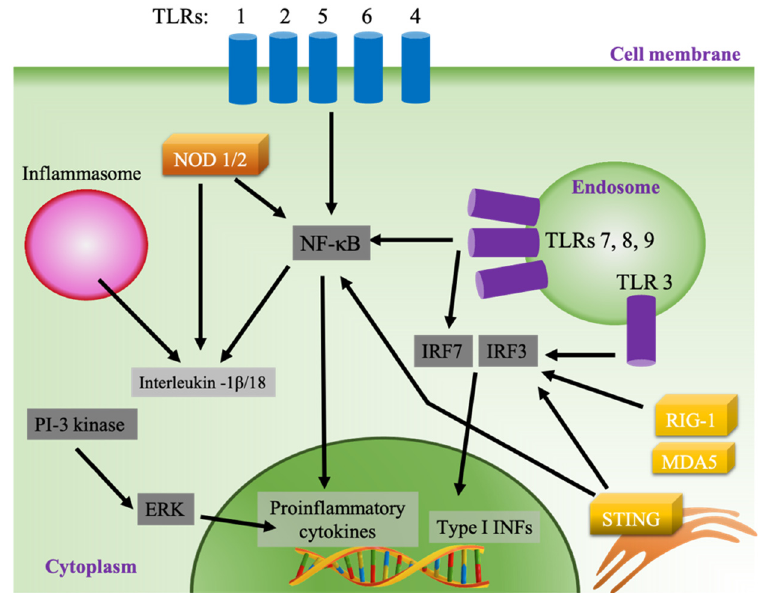
Figure 2. Pathways of innate immune system activation.